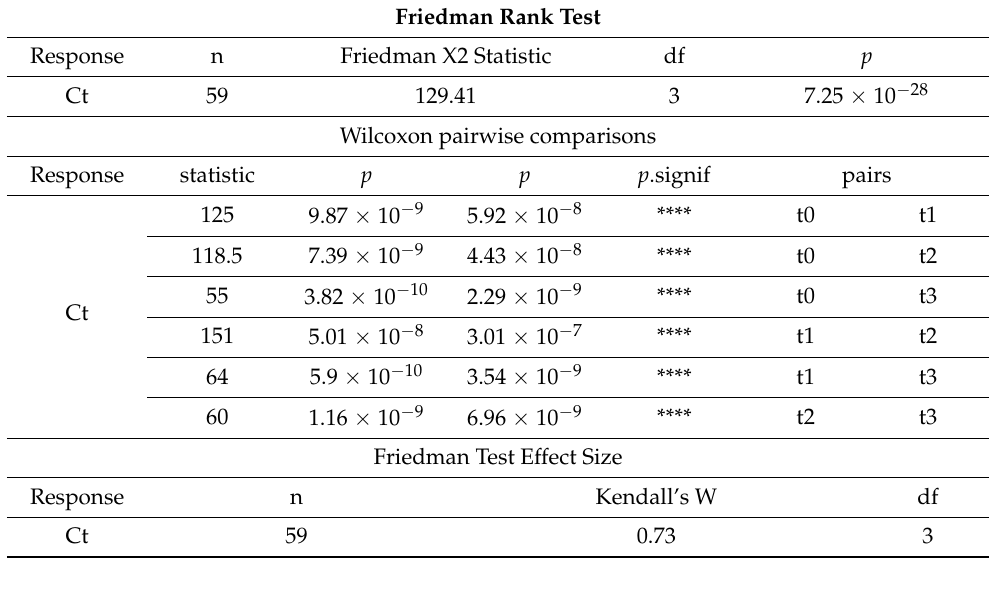
Table 4. The statistical results of the non-parametric test (Friedman, Wilcoxon) for EBV. The asterisks denote significance codes, namely ‘****’ stands for p -value < 0.0001.